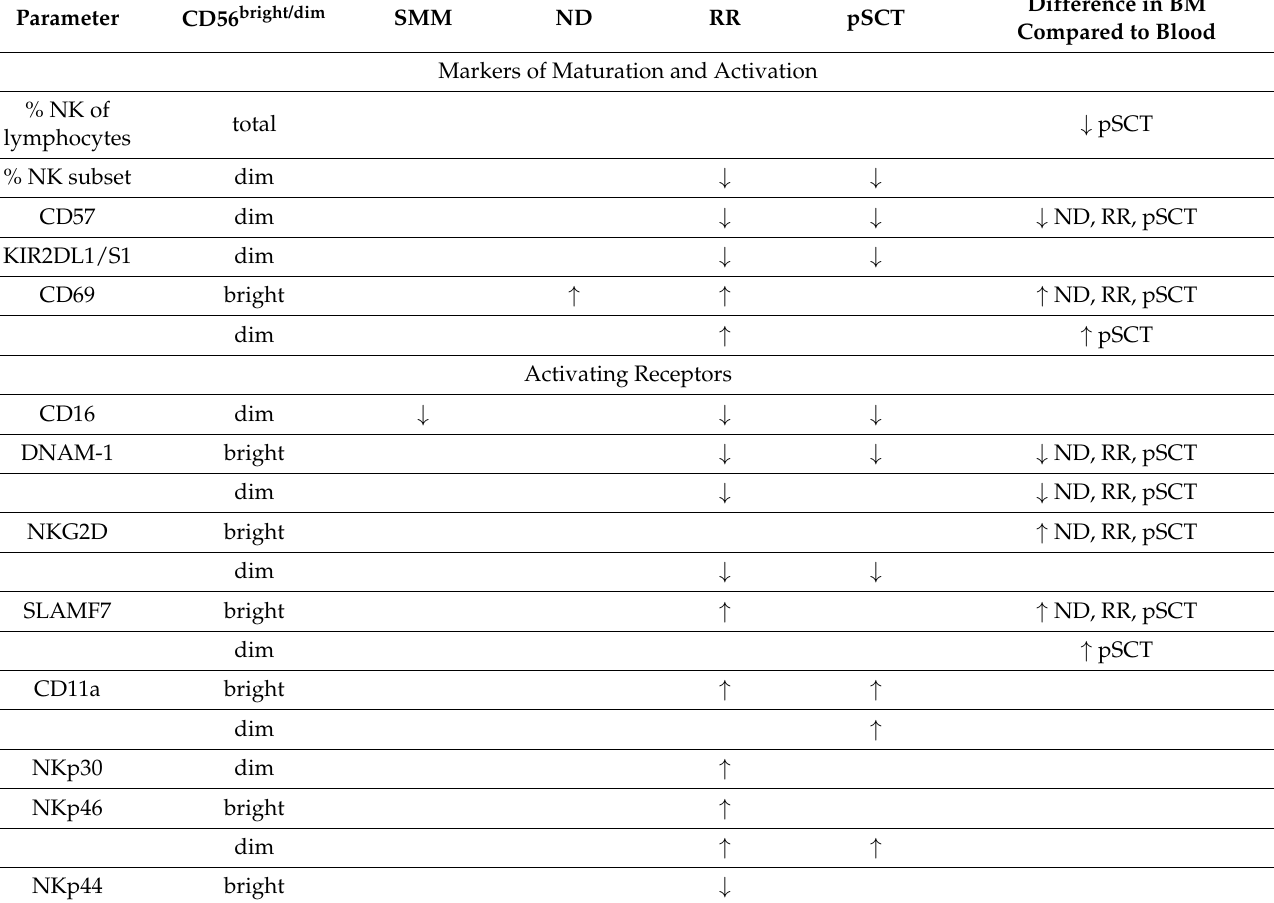
Difference in BM Compared to Blood